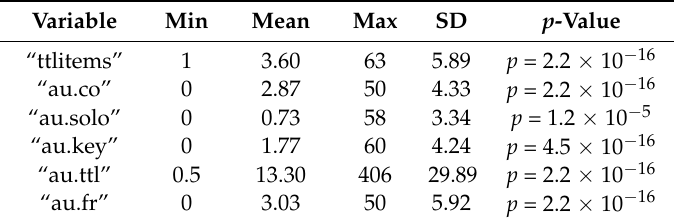
Table 1. A few descriptive statistics for continuous variables.